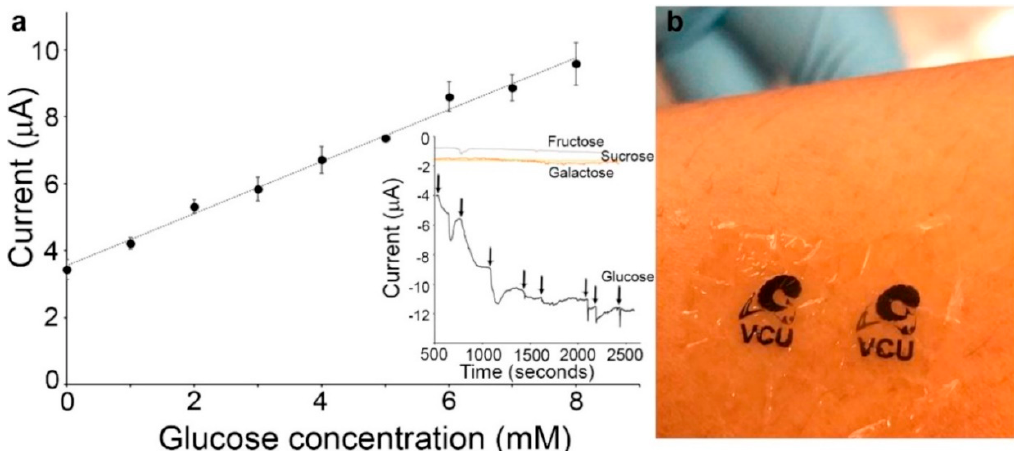
Figure 14. ( a ) SPP-PEDOT:PSS containing immobilized GOx is a selective amperometric sensor for glucose. Response to exposure to other sugars can be seen in the inset. ( b ) Image showing SPP-